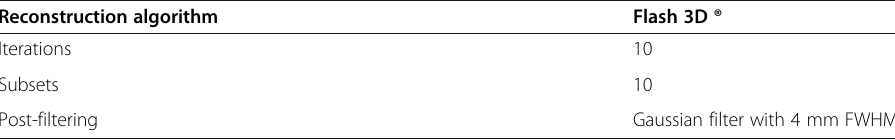
Table 3 Reconstruction parameters for SPECT images Reconstruction algorithm